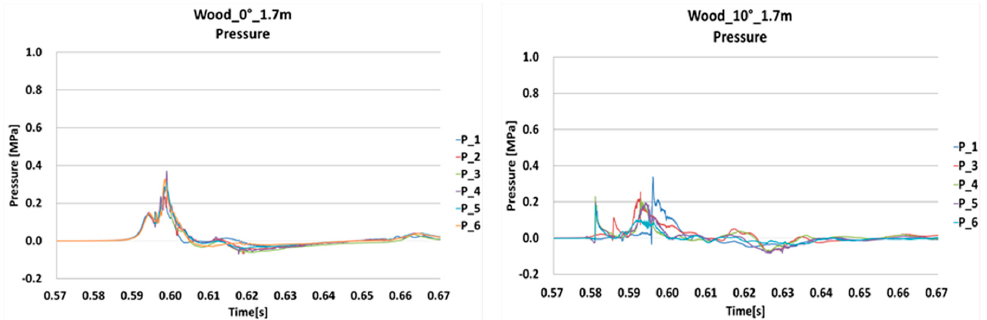
Figure 13. History of pressure in the wooden wedge model with a deadrise angle of 0 ◦ and 10 ◦ (Drop height: 1.7